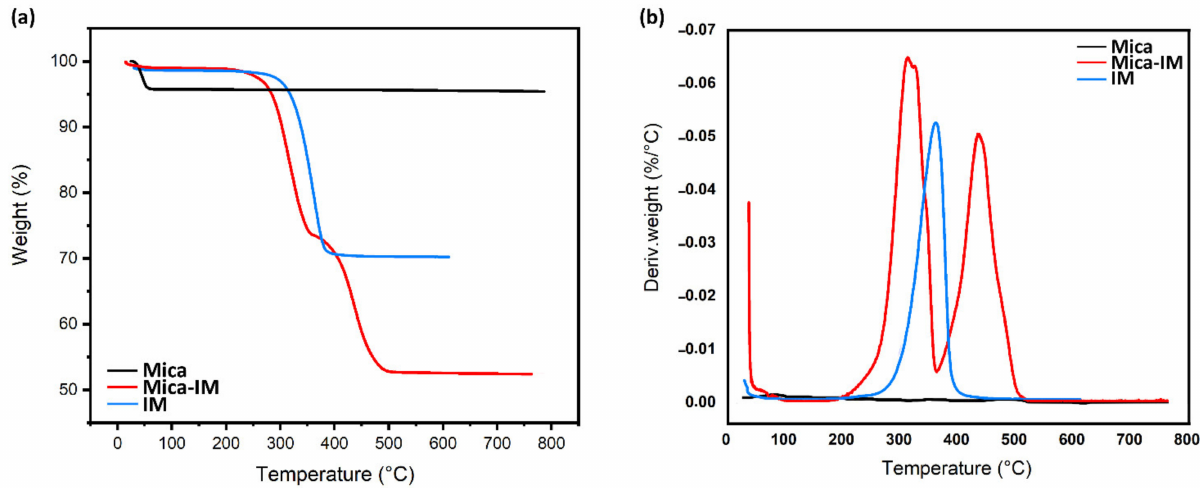
Figure 3. Typical of variation of weight loss, TGA ( a ) and derivative of weight loss, DTG ( b ) of the studied samples vs. temperature (heating rate: 20 ◦ C min − 1 , atmosphere: